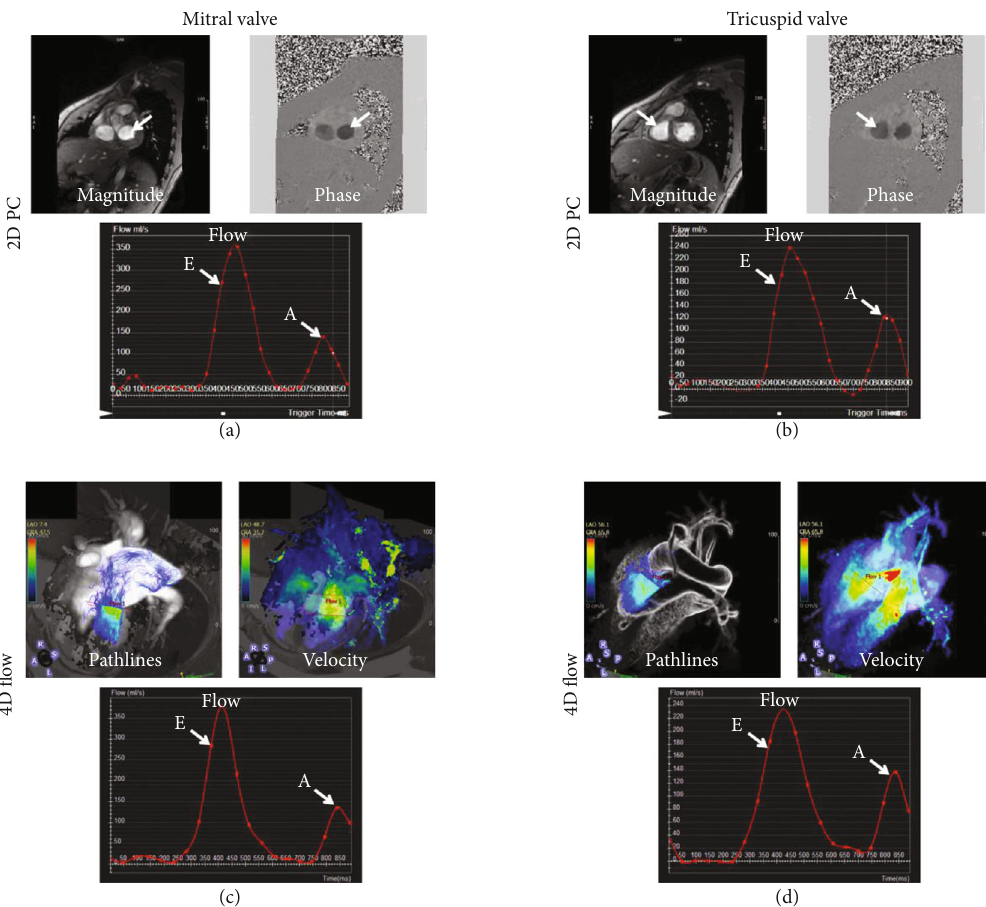
Figure 5: 2D phase-contrast and 4D- fl ow valvular imaging. Representative 2D phase contrast (PC) images and fl ow curves (a, b) and the corresponding 4D- fl ow maps and curves (c, d) at measurement sites across the mitral valve (a, c) and the tricuspid valve (b, d). The images show good agreement between fl ow curves by the two techniques, in addition to the extra information (pathlines and velocity maps) provided by 4D- fl ow acquisition. E: early fi lling peak; A: atrial fi lling